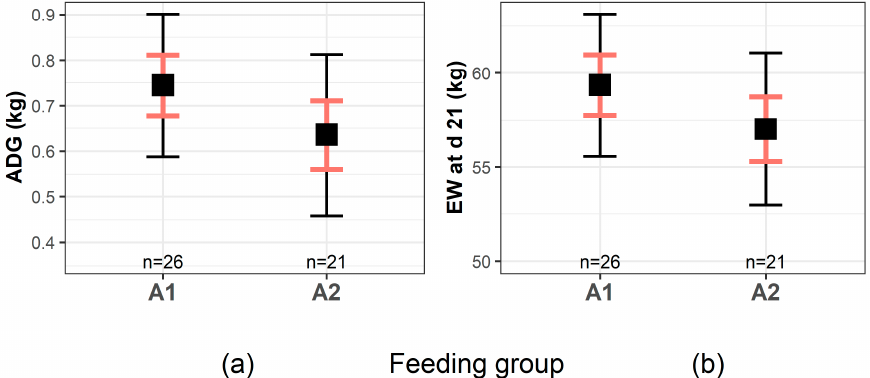
Figure 2. Least squares means for average daily weight gain (ADG, a ) and end weight (EW, b ) of calves receiving either A1- or A2-milk. Red and black bars indicate standard errors and upper-/lower levels of 95% confidence intervals, respectively. n is the number of calves per feeding group.